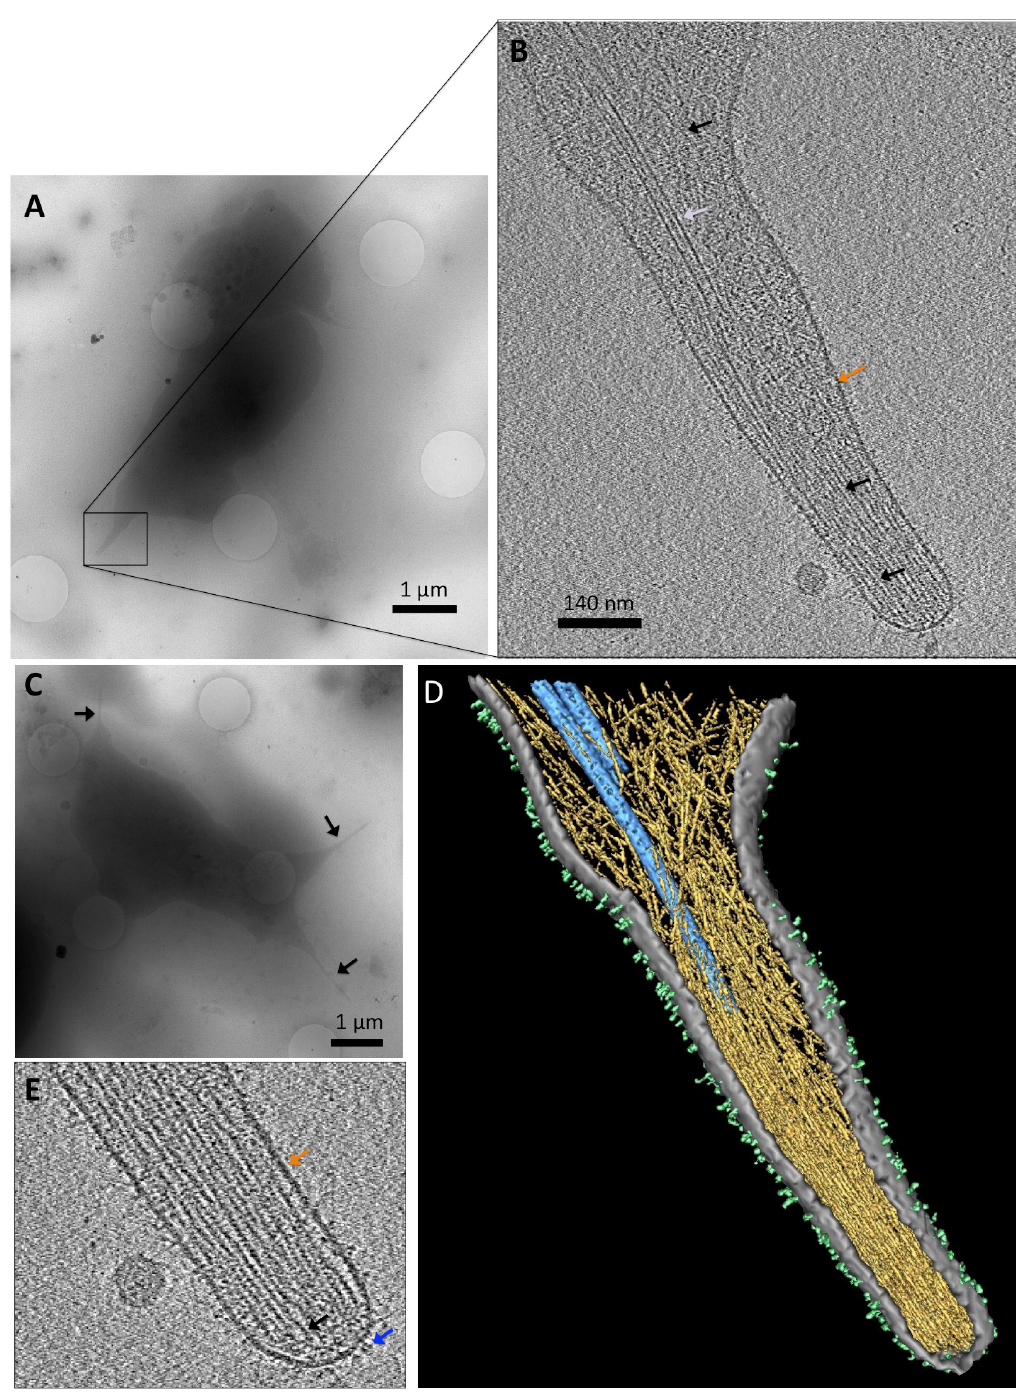
Figure 5. Cryo-electron tomography of a platelet filopodia on collagen IV. ( A ) Low magnification image of a whole platelet with filopodial protrusions. Scale bar: 1 μm. ( B ) The same platelet as in ( A ), with a high magnification image of the filopodia in ( A ), black box. Slice from the 3D reconstructed volume. Visible is the membrane (orange arrow), microtubules (white arrow), and actin (black arrows). Scale bar: 140 nm. ( C ) Low magnification image of a representative platelet with filopodial extensions (black arrows). Scale bar: 1 μm ( D ) Rendered volume of the whole tomogram. Actin in yellow, microtubules in blue, membrane in grey, and surface receptors, many are integrins, in light green. ( E ) Zoom-in view of ( B ), a slice from the 3D reconstructed volume. We are able to see the membrane (orange arrow), actin (black arrow), and surface receptors resembling integrins (blue